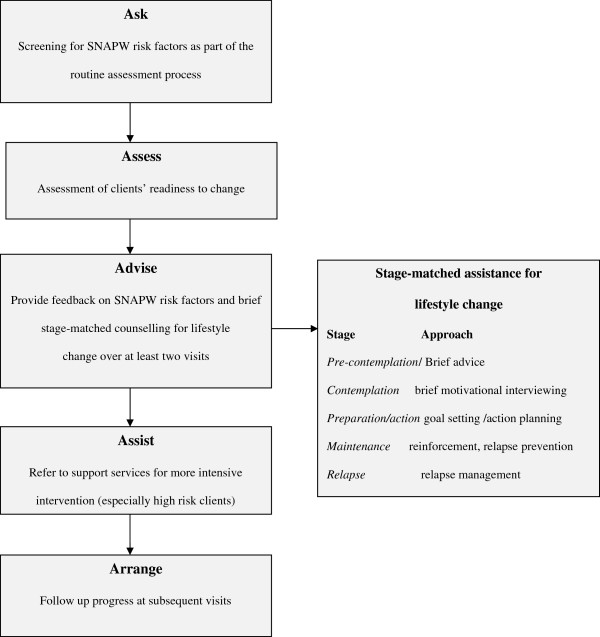
5As model of brief lifestyle intervention.